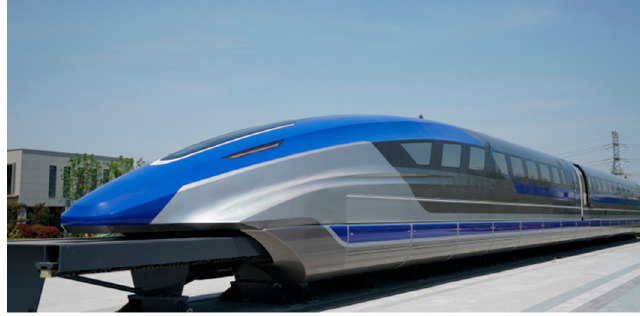
Figure 10. 600 km/h high-speed maglev train with waterborne polyurethane coatings. Figure 10. 600 km / h high-speed maglev train with waterborne polyurethane